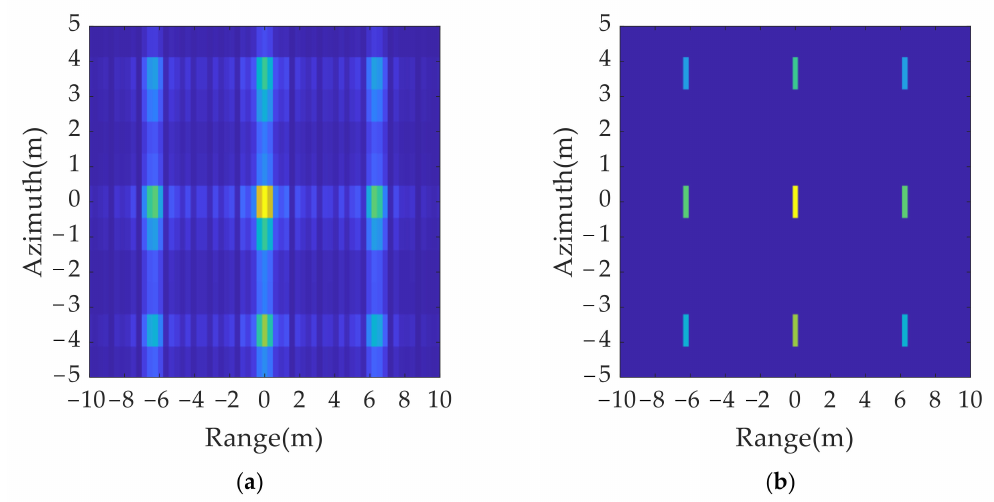
Figure 12. 2D deception jamming results by twinning waveform: ( a ) jamming results without eliminating sidelobe; ( b ) jamming results after eliminating sidelobe.